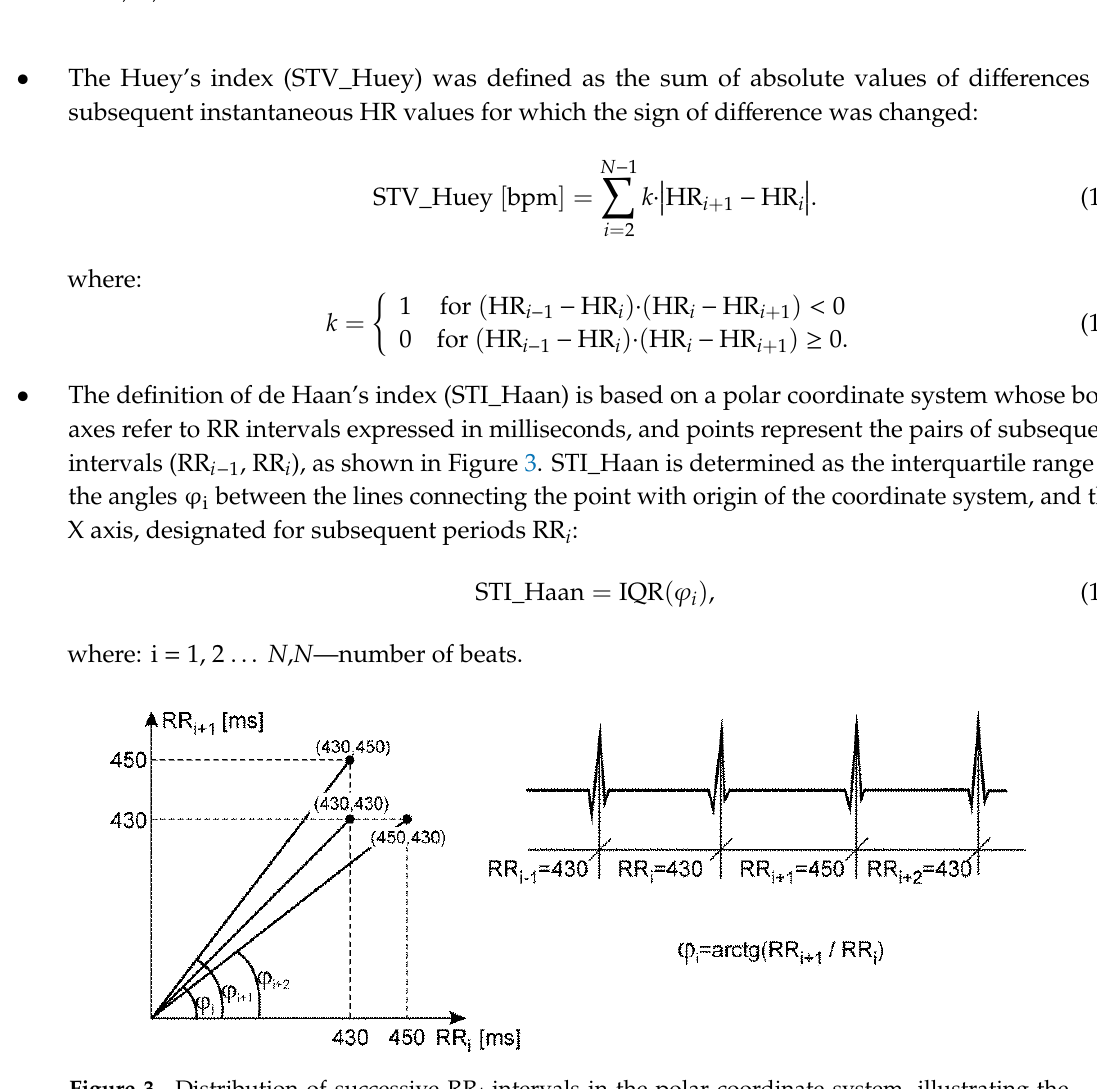
Figure 3. Distribution of successive RR i intervals in the polar coordinate system, illustrating the definitions of the de Haan’s index describing the short-term HR variability.